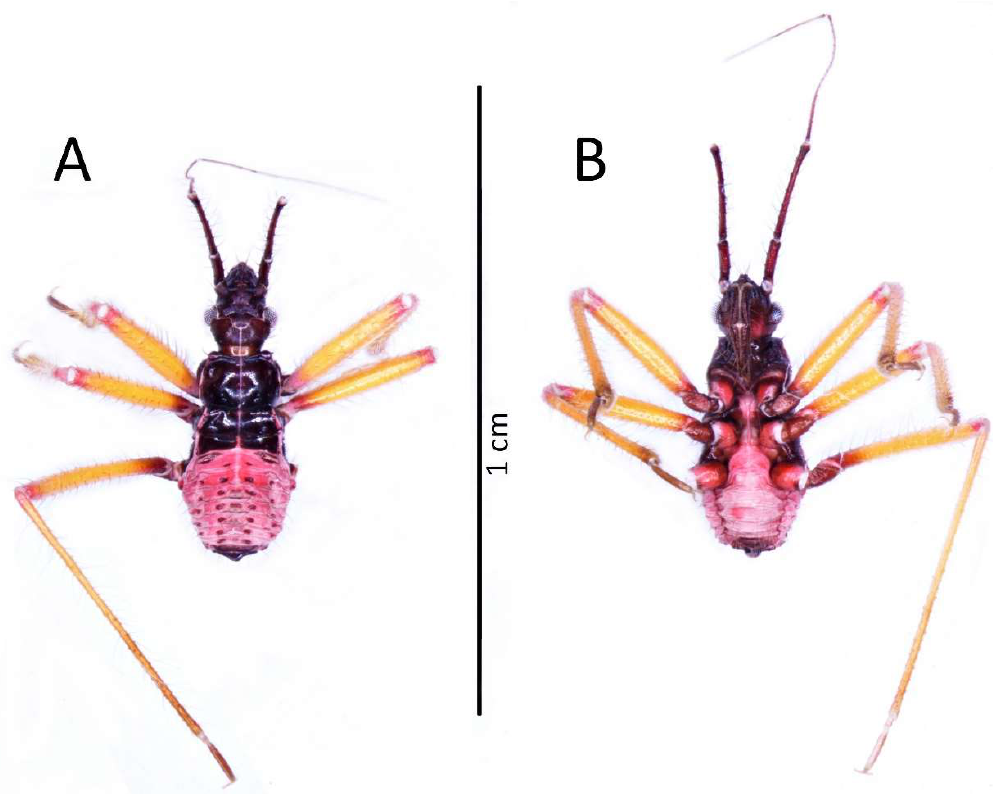
Figure 3. ( A ) Dorsal and ( B ) ventral habitus of the first instar of Psyttala horrida (Stål, 1865). Structure: Body dull with shiny head and thorax, covered by various-sized setae (Figure 4). Head with medium-sized and long setae. Ecdysial line visible in lateral parts of transversal suture of the head (Figure 3). Regarding the postocular area, the middle part of the ecdysial line is u-shaped and connected with a longitudinal ecdysial line placed in 1/2 of the postocular part and on the neck. Eyes prominent. Clypeus covered by long setae, mandibular and maxillary plates covered by medium-sized setae. Labrum visible along the whole length of the first visible labial segment. All labial segments covered by long setae (Figure 5A,B). Stridulitrum well developed, in the form of a gutter. Stridulatory furrow with regular stripes and flanked by lateral papillae (Figure 5B,D). Scape short and wide. Pedicel slightly thinner than the scape, both segments covered by long, erect, and robust setae. End of pedicel with single antennal trichobothrium . Basiflagellomere the longest, covered by long, erect, and regularly placed setae. Distiflagellomere, covered by few long, erect setae and short, dense, adherent setae (except 1/6 of basal part). Neck without setae. Pronotum covered by a few long, regularly placed setae. Mesonotum with two long setae (Figure 5C). Propleuron without setae, mesopleuron with two long setae on each side, and metapleuron with one seta on each side. Prosternum with two long setae near stridulitrum. Metanotum without setae in dorsal view. The whole thorax covered with short and robust spine-like processes (in this stage, visible at very high magnification (Figure 6A). Coxa with long, arranged in regular line setae (Figure 6B). Ventral apical part of fore- and mid-tibia covered by a pad of barbed setae (Figure 6C). Foretibial comb not on the spur (Figure 6C,D). On each abdominal segment, visible long setae placed on distinct sclerotised plates and arranged in transversal rows—four setae on each segment, except for the row on the first abdominal segment, which contains only two setae. A pair of long setae visible on lateral margins of each abdominal segment. In dorsal view, large evaporatory area of dorsal abdominal glands visible between segments III/IV, IV/V, and V/VI. Segments IX and X with visible sclerotised plates of tergites. Ventral side of the abdomen covered by transversal rows of long and thin setae (one row on each segment) without any sclerotised